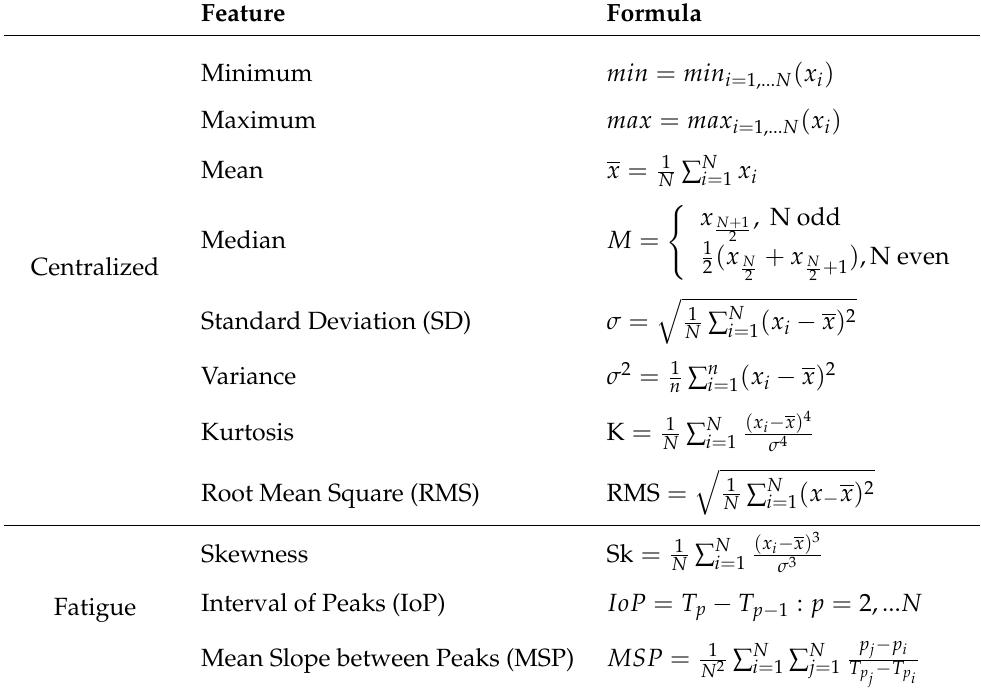
Table 2. Eleven hand-crafted features: eight HAR-related features and three fatigue-related